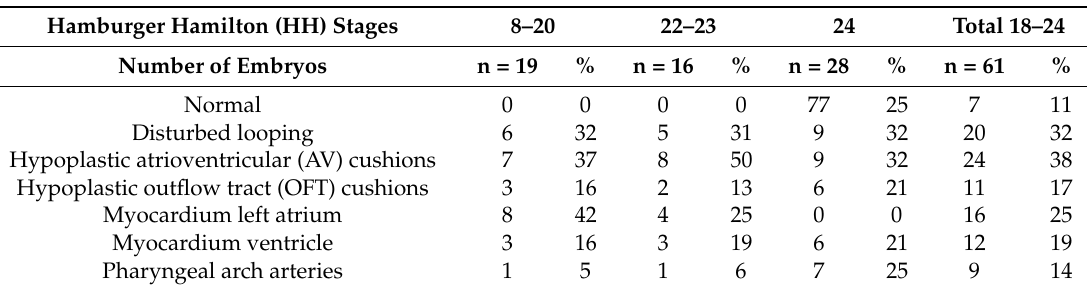
Figure 1. Cardiac looping in normal and ligated embryos HH20. Scanning electron micrograph (SEM) of ventral views. ( a ) Normal embryo with cardiac segments indicated. ( b ) Ligated embryo. The retarded looping resembles that of a HH17 embryo with an open inner curvature (*). The AV canal is relatively long. ( c , d ) Interior view of dorsal heart halves. ( c ) The inferior AV cushion and the OFT cushions are well developed, ventricular trabeculations have formed. ( d ) AV and OFT cushions are non-existent, spongy trabeculations and the compact myocardium is thin (arrowheads). AV: Atrioventricular groove, DOT: distal OFT, IAV inferior AV cushion, LA: left part of atrium, M: compact myocardium, OTC: OFT cushions, POT: proximal OFT, VI ventricular inlet, VO: ventricular outlet, * inner curvature, arrowheads: thin compact myocardium. Table 1. Cardiovascular abnormalities after ligation. The number and percentage of malformations are indicated for each stage. Different malformations were sometimes observed in the same embryo, therefore, the sum of a column can exceed